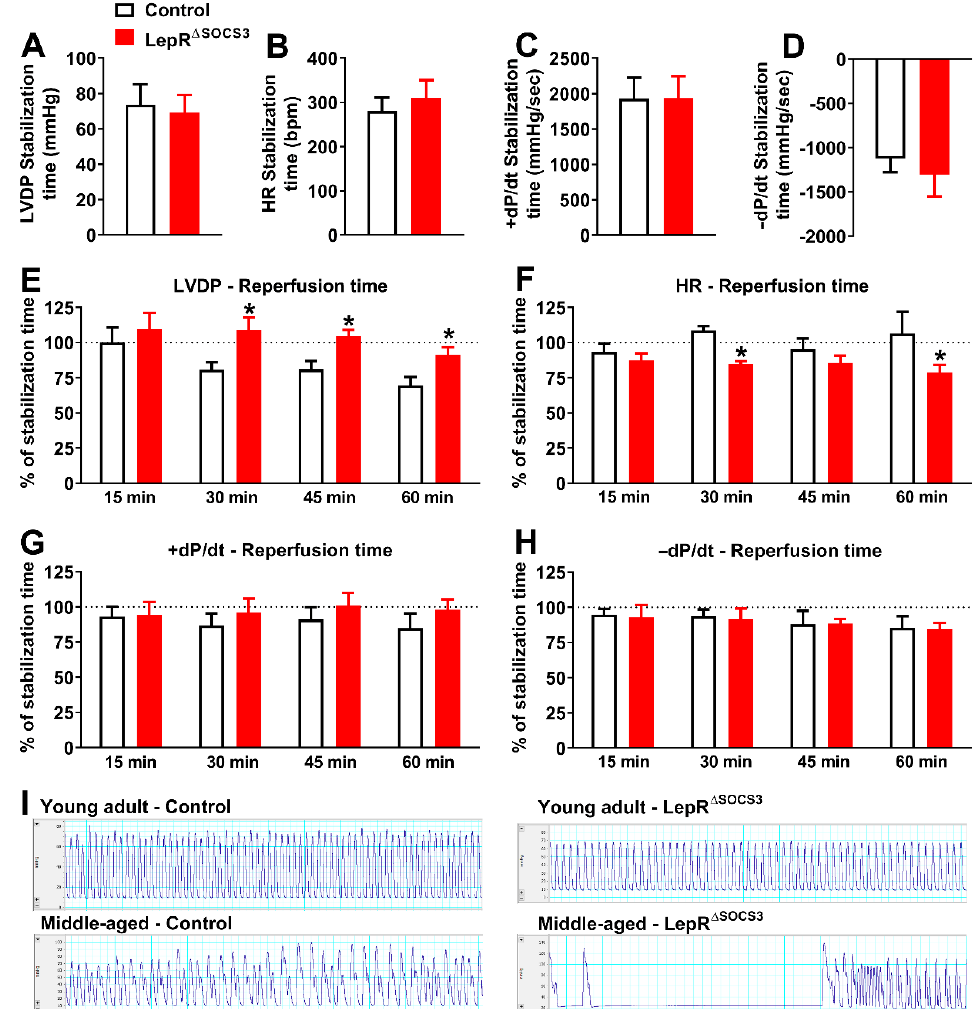
Figure 8. Substantial arhythmic events during the reperfusion period in middle-aged LepR Δ SOCS3 mice despite an apparent improvement in the post-ischemic cardiac functional recovery. ( A – D ) Baseline cardiac functions including left ventricular developed pressure (LVDP), heart rate (HR), first derivative of the positive (+dP/dt) and negative ( − dP/dt) ventricular pressure in middle-aged control ( n = 7) and LepR ∆ SOCS3 ( n = 6) mice. ( E – H ) Temporal analysis of cardiac parameters at 15, 30, 45 and 60 min of reperfusion in middle-aged mice. ( I ) Representative recordings during the reper- fusion period showing a robust arhythmic event in middle-aged LepR Δ SOCS3 mice. Mean ± SEM. * p < 0.05 control vs. LepR ∆ SOCS3 (post-hoc test repeated measures two-way ANOVA).